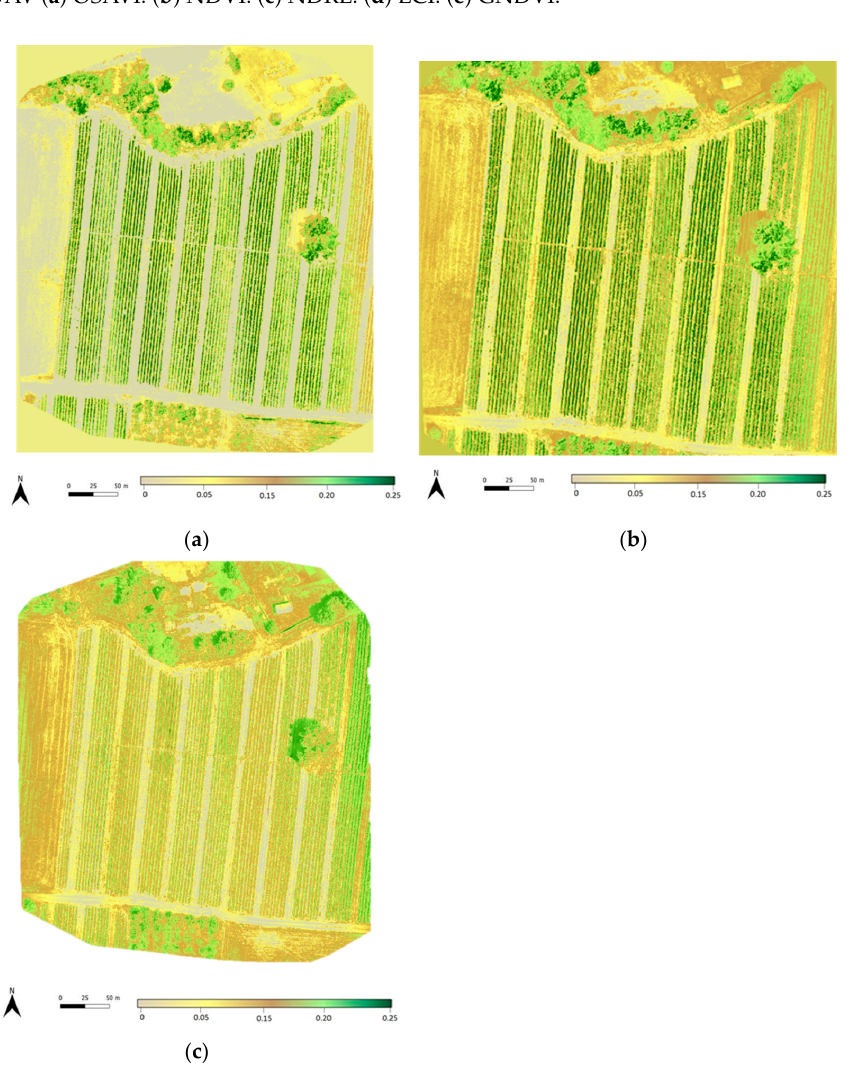
Figure A4. Biophysical parameters derived from UAV data for Katunica, Bulgaria pepper field ( a ) FAPAR (Fraction of Absorbed Photosynthetically Active Radiation), ( b ) fCover (Fraction of Vegetation Cover), and ( c ) LAI (Leaf Area